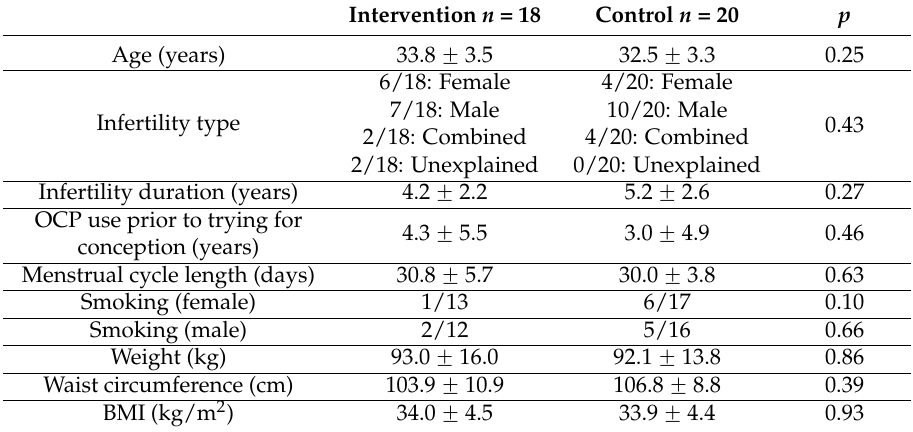
Table 1. Baseline characteristics and anthropometric and fertility changes in women undertaking assisted reproduction treatment (ART) randomised to either dietary and exercise treatment or